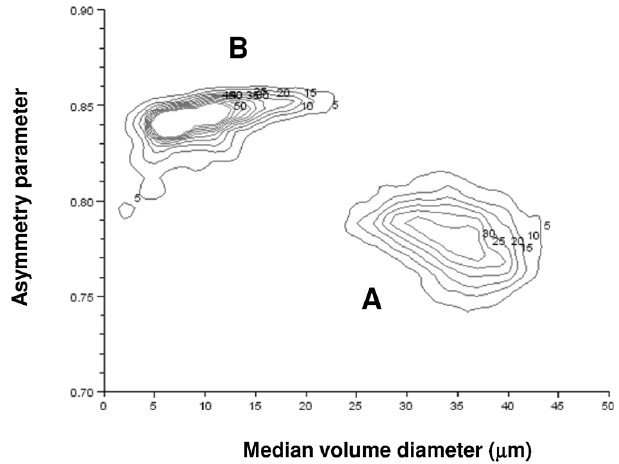
Fig. 5. Mean volume diameter–asymmetry scatter plots of the FSSP-100 and Polar Nephelometer measurements obtained in mixed-phase clouds during ASTAR and POLARCAT experiments ( ∼ 30000 data). The number of observations are represented by iso- lines.